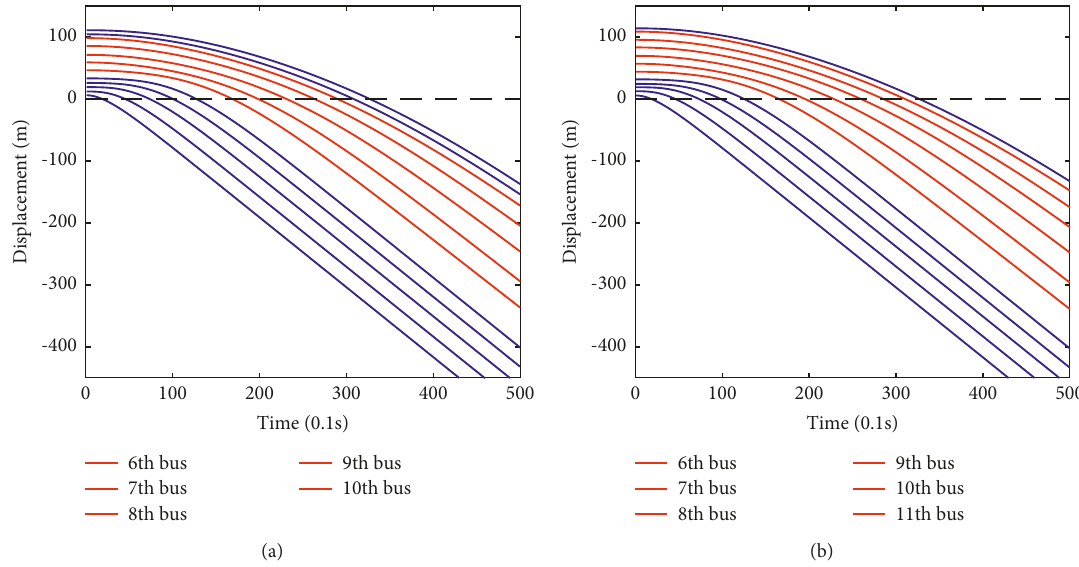
Figure 22: The numerical simulation diagram in 40–50% heavy vehicles scenario. (a) The 5th bus in the queue. (b) The 6th bus in the